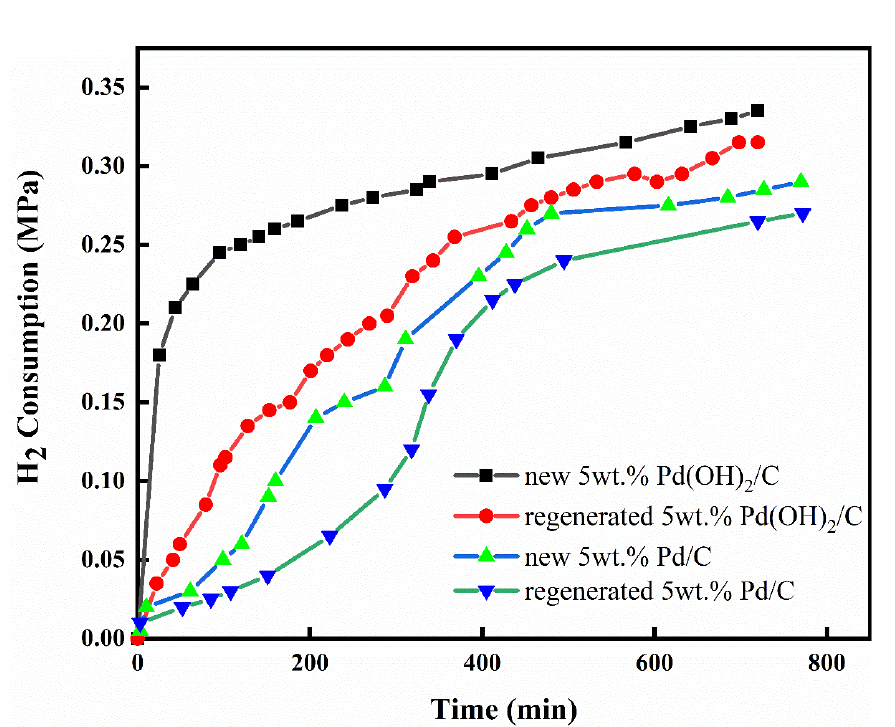
Figure 1. The hydrogen consumption curve for new and regenerated catalysts. Figure 1. T he hydrogen consumption curve for new and regenerated catalysts. Reaction conditions: 5 g HBIW, 0.5 g regenerated catalyst, 50 mL of DMF, 7 mL of Ac 2 O and 0.1 mL of PhBr. The reaction was carried out at 19–20 ◦ C for 4 h, and at 40 ◦ C for another 8